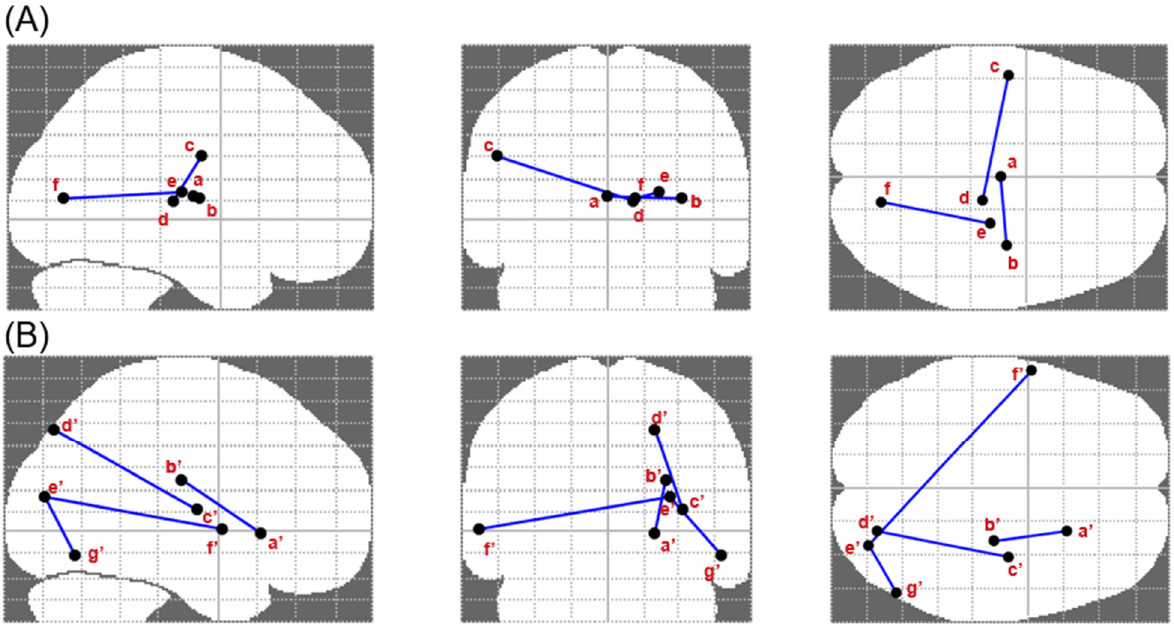
Figure 2. Comparisons of functional connectivity between the patient and healthy control groups. Significantly different functional connectivity between brain regions are displayed on the glass brain template (SPM–NBS) as links joining the corresponding functional nodes. ( A ) Patients with substance use disorders exhibited higher functional connectivity between the medial thalamus (a) and the posterior insula (b), higher functional connectivity between the somato-motor region of the inferior central sulcus (c) and the posterior thalamus (d), and higher functional connectivity between the globus pallidus (e) and the cuneus (f). ( B ) The control group demonstrated increased functional connectivity relative to the patients between the anterior putamen (anterior capsule limb, a ′ ) and the posterior corona radiata (superior longitudinal fasciculus, b ′ ), within the visual cortices (superior, e ′ , and inferior occipital gyrus, g ′ ) and the contralateral superior temporal gyrus (f ′ ), and between the superior occipital gyrus (superior part, d ′ ) and the posterior insula (c ′ ).